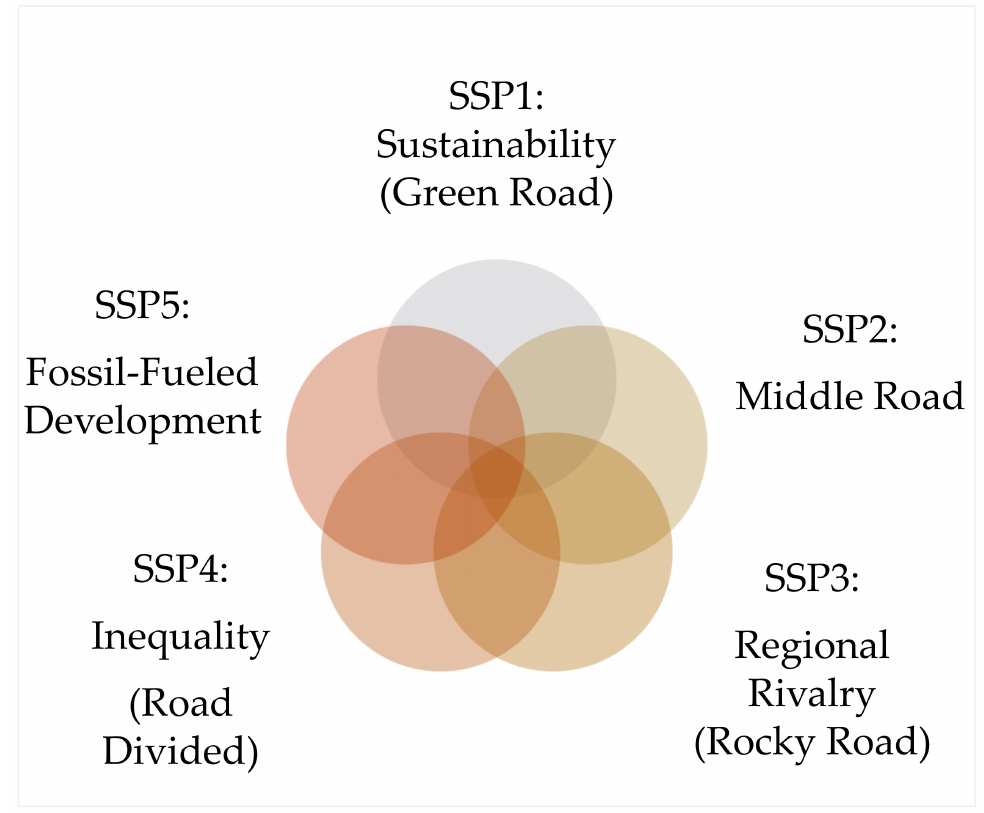
Figure 2. SSP1–5